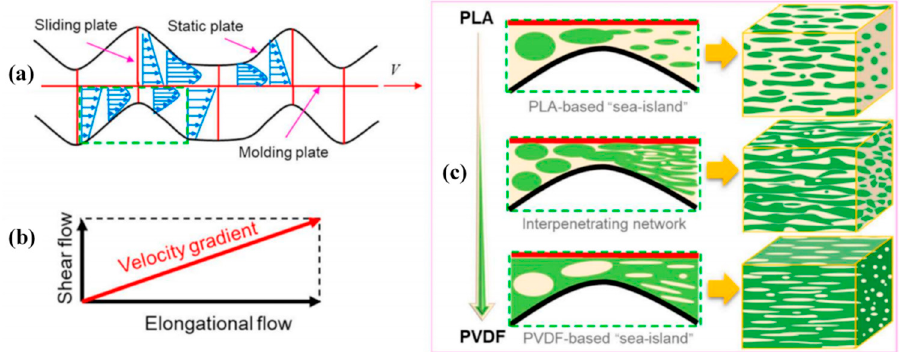
Figure 8. The schematic illustration of ( a ) simplified flow field in twin-eccentric rotor extruder (TERE), ( b )velocity gradient, and ( c ) morphology evolution of PLA/PVDF composites. Reproduced with permission from [50]. Copyright 2021, Elsevier.